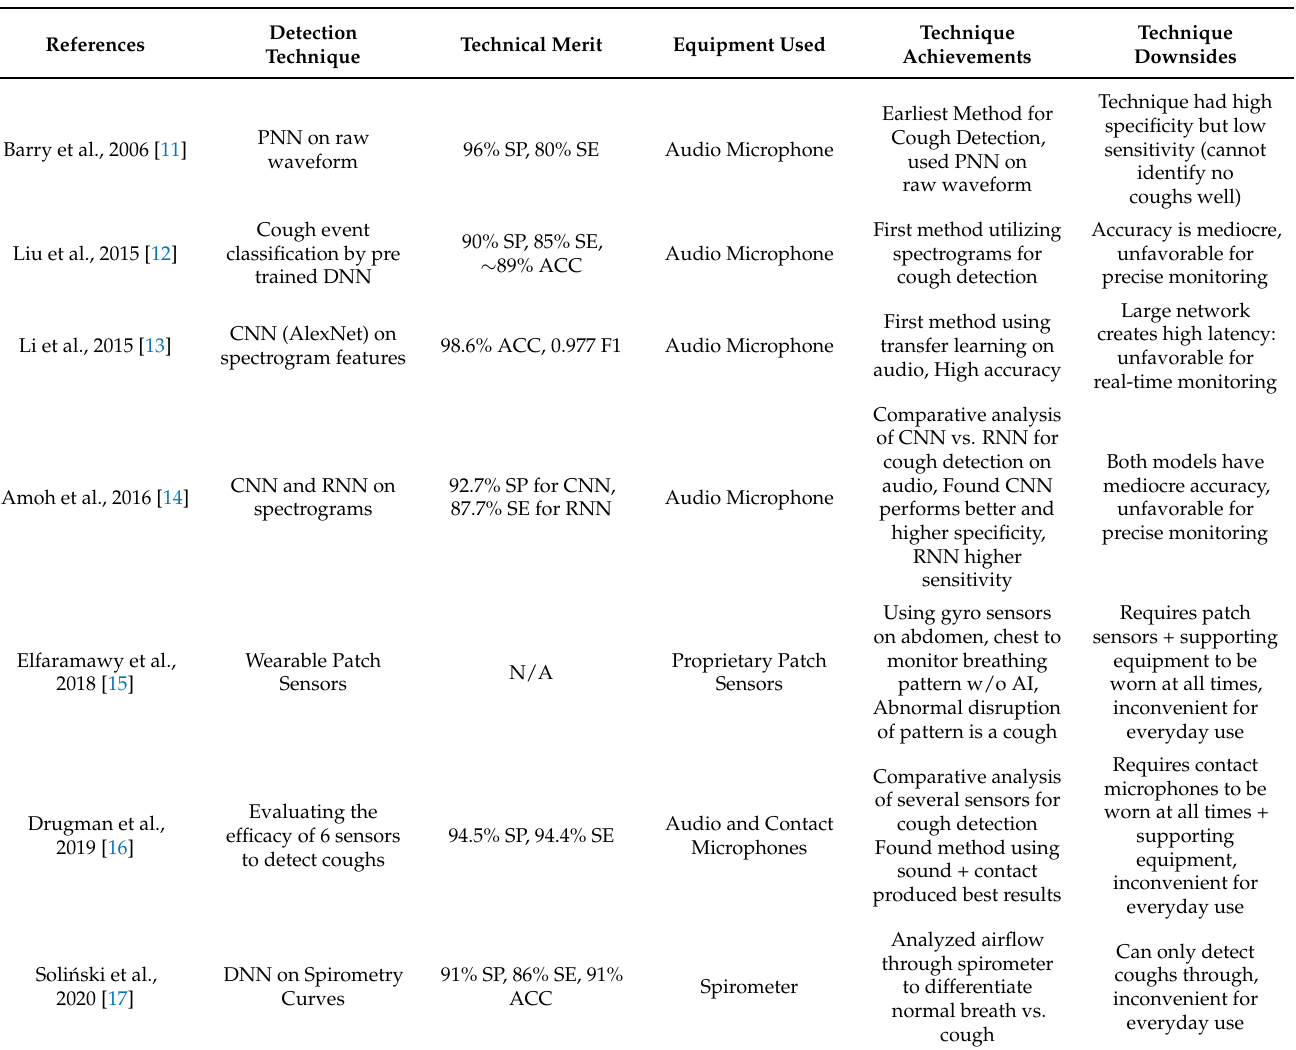
Table 1. A survey of previously reported techniques for automatic cough detection (P/C/R/ DNN = Probabilistic/Convolutional/Recurrent/Deep Neural Network; SP = Specificity; SE = Sen- sitivity; ACC = Accuracy). The above techniques follow these observations: (i) generally higher accuracies were achieved with more complex models utilizing spectrograms; (ii) techniques aided with extra equipment produced better results; (iii) no single technique simultaneously meets all of the following requirements: highly accurate, efficient, passive and continuous monitoring, does not need extra